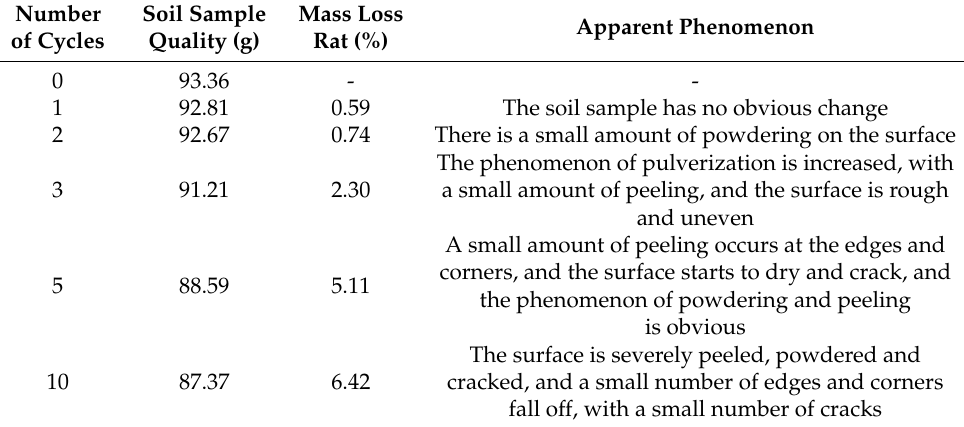
Table 4. Record of constant temperature dry wet cycle test of soil sample A-0.